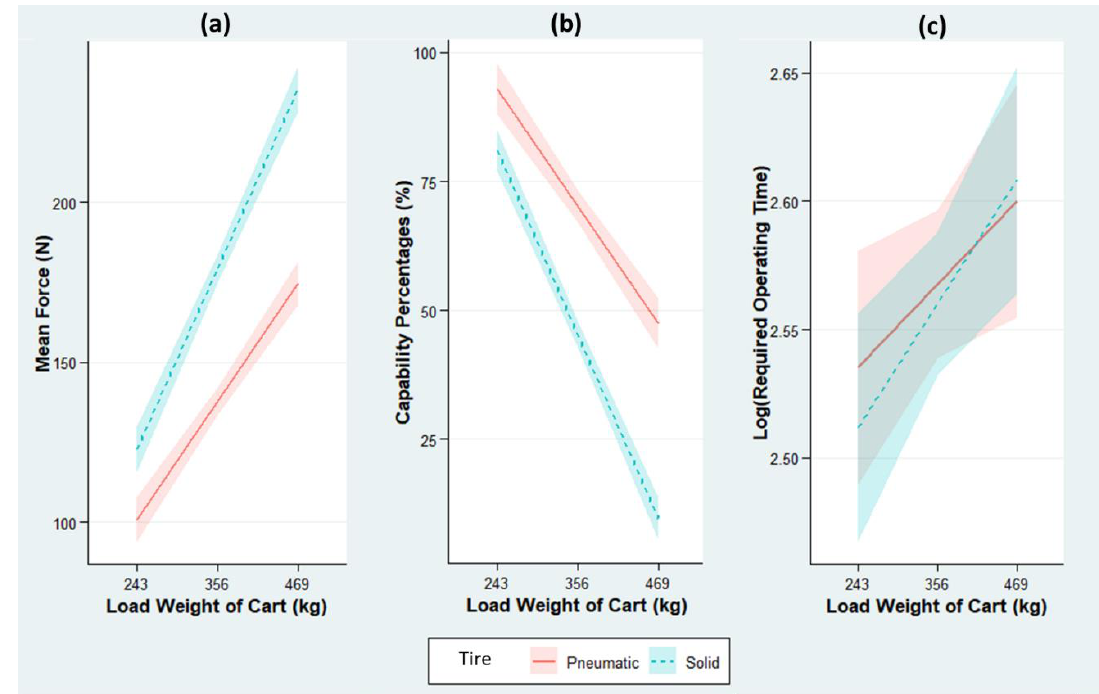
Figure 5. Estimated values: ( a ) ROF, ( b ) CP, and ( c ) ROT for two tire types by fitting the actual measurements in Experiment 1b from the final linear regression models. The ribbons indicate 95% confidence intervals.